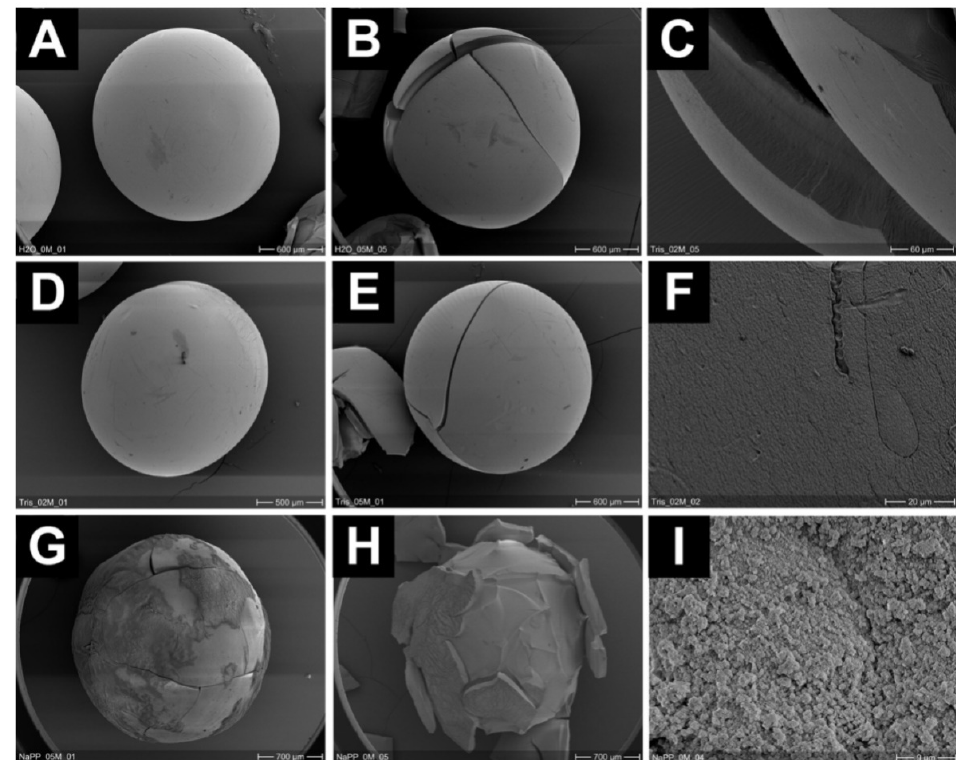
Figure 18. SEM images of silica-coated alginate beads before and after mechanical stress test. Alginate solution was prepared in water ( A , B ), Tris/HCl buffer ( C – F ), or sodium phosphate buffer ( G – I ), and beads were cured in 0.5 M calcium chloride. Coating was performed with pure TMOS for all beads shown. ( A , D , G ): Beads before the stability test. ( B , E , H ): Cracked beads after the stability test. ( C ): Close-up of breaking edge. Surface details of a bead prepared from Tris − HCl-alginate ( F ) and sodium phosphate-alginate ( I ). Reprinted with permission from [131].